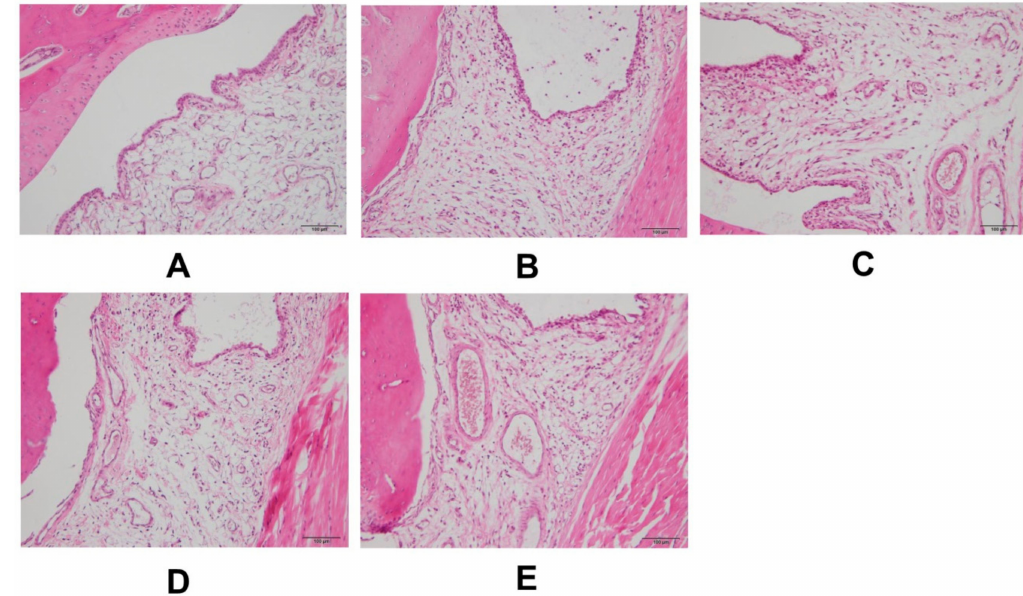
Figure 2. Representative H&E stained slices of synovial tissues in ankle specimens 48 h after intra-articular injection of MSU crystals: ( A ) Control group, ( B ) gout group, ( C ) colchicine group, ( D ) CH group, and ( E ) CL group. 200 ×